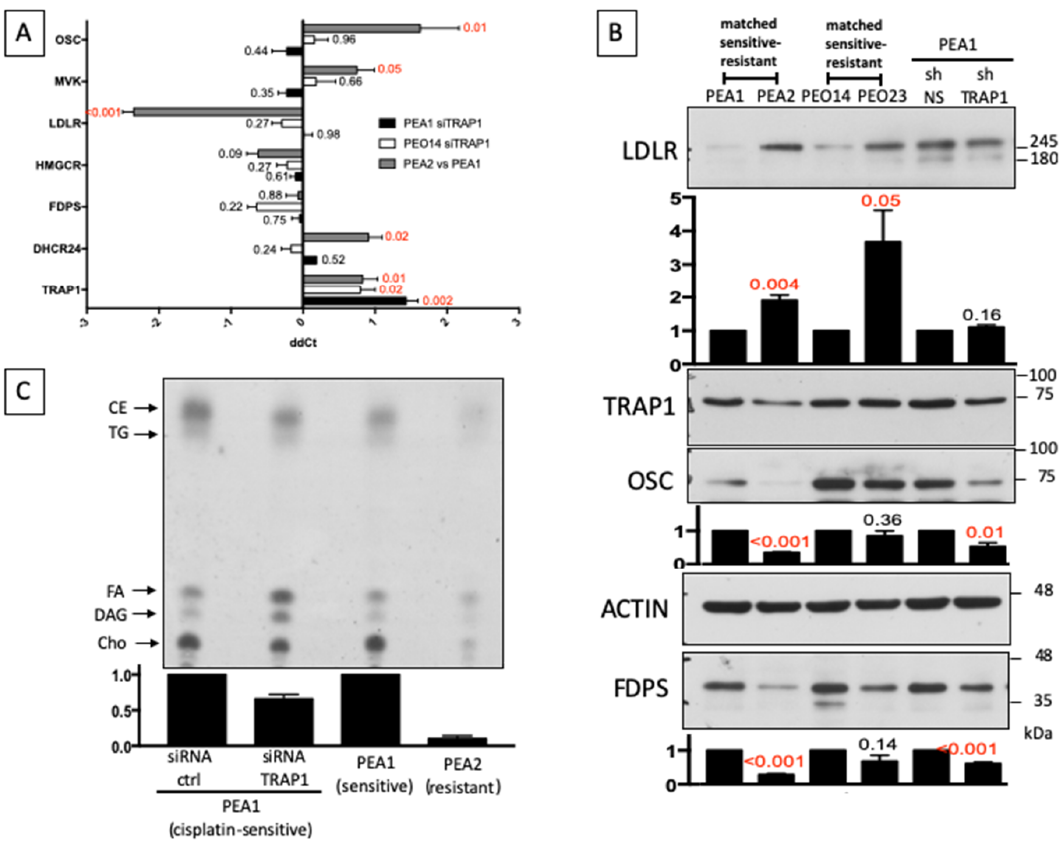
Figure 2. Drug-resistant cells remodel cholesterol homeostasis. ( A ) Real-time RT-PCR analysis of expression of genes belonging to the cholesterol pathway in PEA1 and PEO14 upon siRNA-mediated TRAP1 silencing and in PEA2 compared to PEA1. All data are expressed as mean ± S.E.M. of delta-delta Ct (ddCt) from six (PEA1 siTRAP1), three (PEO14 siTRAP1), or four (PEA2 vs. PEA1) independent experiments with technical triplicates each. Numbers indicate the statistical significance ( p -value), based on Student’s t -test (significant values highlighted in red). ( B ) Total lysates obtained from PEA1, PEA2, PEO14, and PEO23 cells or from stable TRAP1 knockdown PEA1 cells (shTRAP1) and their respective nonsilencing controls (shNS) were separated by SDS-PAGE and immunoblotted with the indicated antibodies. Images are representative of three independent experiments. Bar plots below panels show mean ± S.E.M. of relative densitometric band intensity calculated by assuming each band of the control condition (normalized on Actin) = 1 ( n = 3). The number above the bars represent the statistical significance ( p -value) based on the Student’s t -test (significant values highlighted in red). ( C ) [ 14 C]-acetate incorporation in neo-synthesized lipids. Chromatogram of non-saponifiable lipids from PEA1 cells following siRNA-mediated TRAP1 silencing and from PEA1 and PEA2 cells, radiolabeled for 2 h. Cholesterol (Cho), diacylglycerols (DAG), fatty acids (FA), triacyglycerides (TG), and cholesteryl esters (CE) are indicated with arrows. Image is representative of two independent experiments. The bar plot shows mean ± S.E.M. of relative cholesterol densitometric band intensity calculated by assuming each band of the control condition = 1.